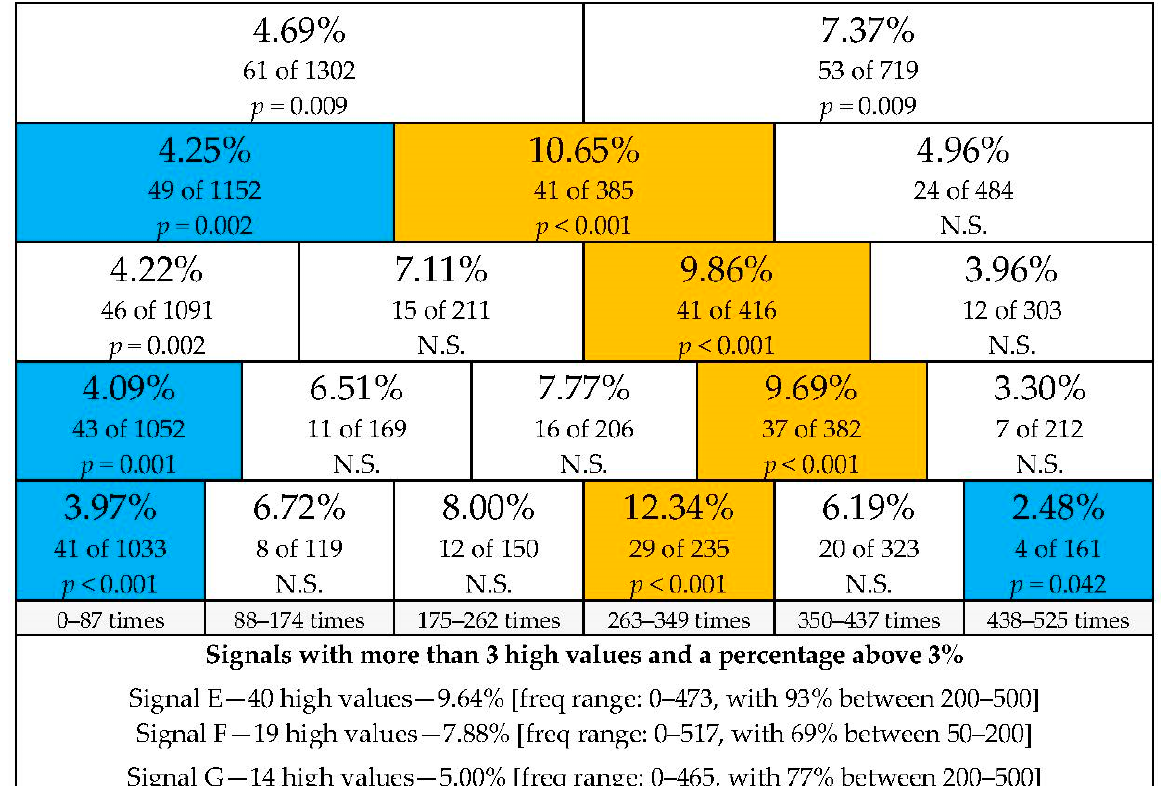
Figure 15. Entrance at yellow effect (analysis 2a). This figure shows the results when the frequency in the last 14 days was split in five different ways for the subset: mean deceleration value 0.5–0.6 m/s 2 , without signal SIGNAL D. Percentages reflect the percentage of high values in this segment. The numbers below indicate the number of high values and the total. Orange indicates that the percentage is significantly higher than expected and blue indicates a percentage significantly lower than expected. White color indicates no significance. The frequency ranged from 0 to 525. The mean percentage was 5.6%.